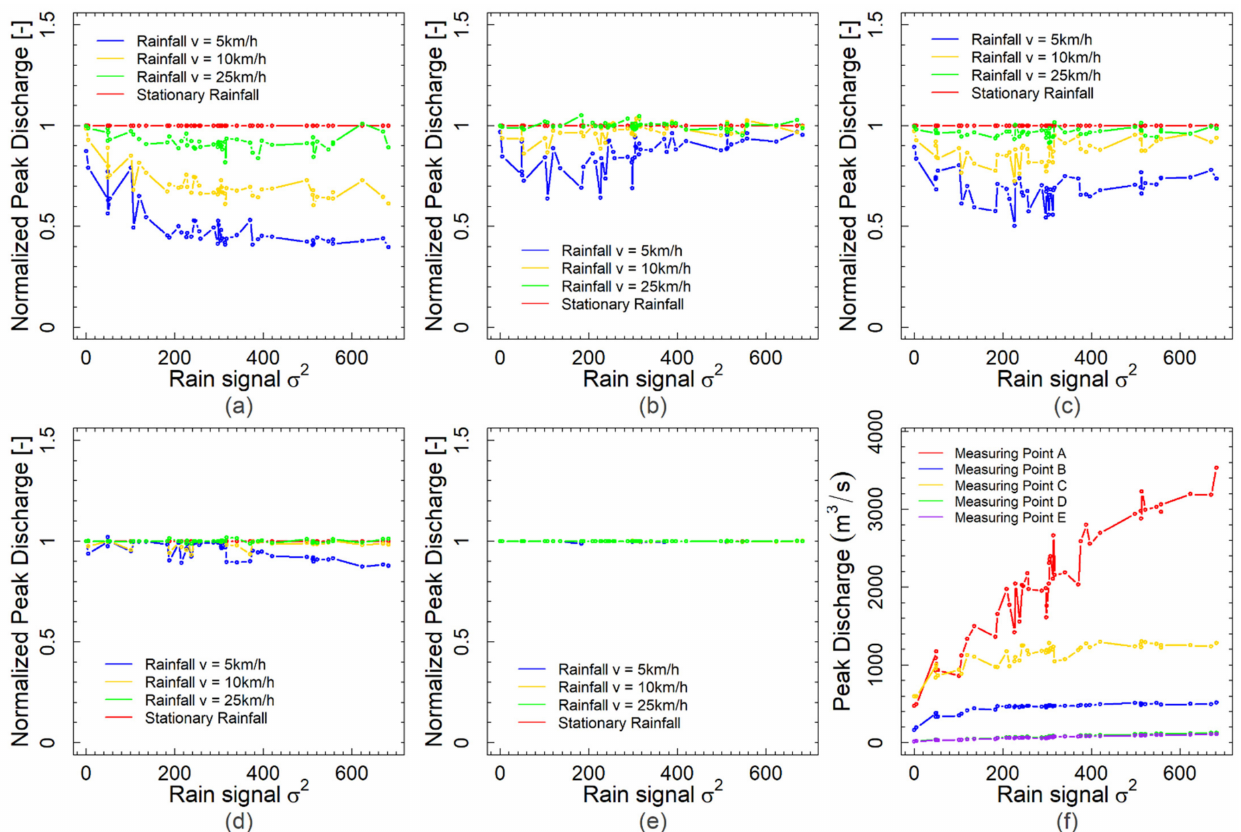
Figure 8. Peak discharge normalized by the peak discharge of the stationary scenario for rains under the stationary and moving setups with velocities v = 5 km/h, v = 10 km/h, v = 25 km/h with a direction from west to east at measuring points A ( a ), B ( b ), C ( c ), D ( d ) and E ( e ). The absolute peak discharge values of the stationary rain setups for the five measuring points are shown in ( f